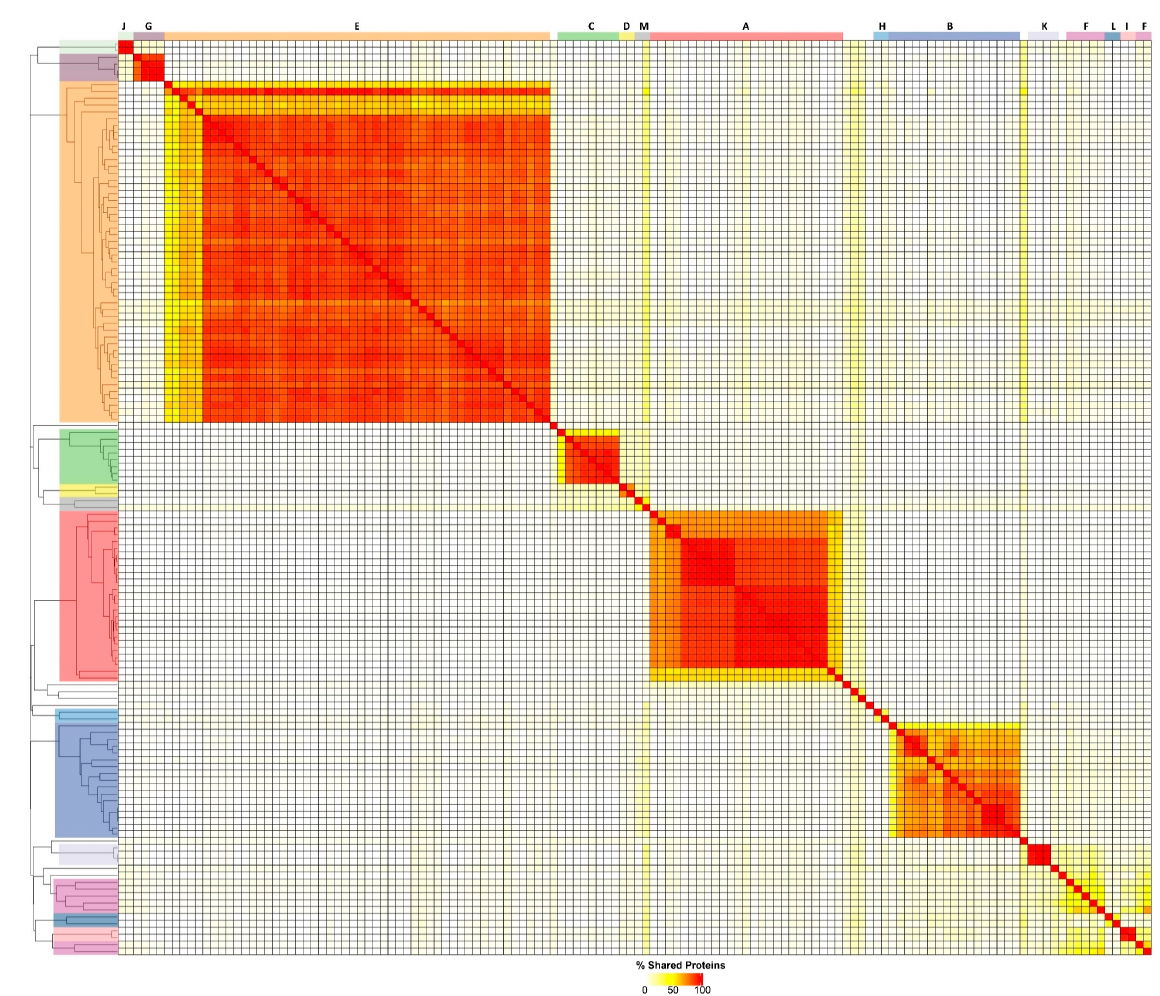
Figure 1. Heatmap of the percentage of proteins shared between pairs of Acinetobacter phage genomes. The heatmap was produced from the output of the PIRATE pan-genome analysis and hierarchically clustered using the complete linkage method in R. Clusters are indicated by coloured blocks at the top of the heatmap and within the dendrogram according to the key: